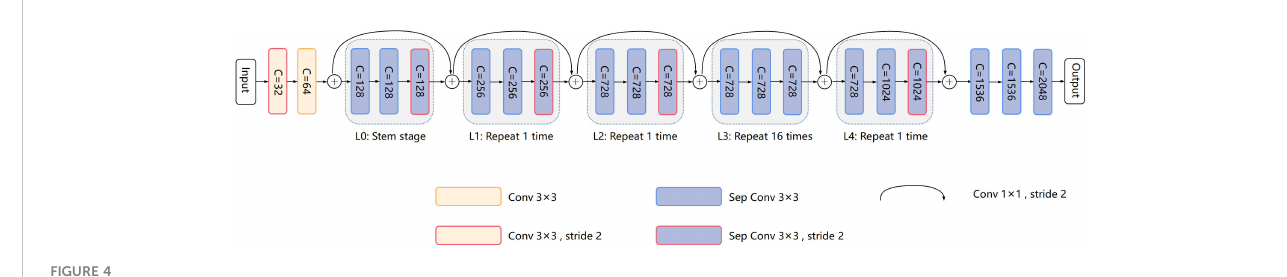
FIGURE 4 Xception. C represents the number of feature output channels.